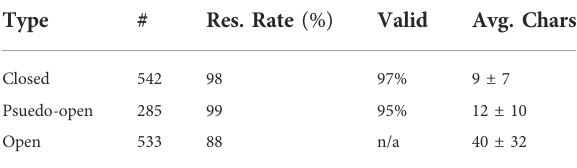
TABLE 3 Question response rates and lengths.